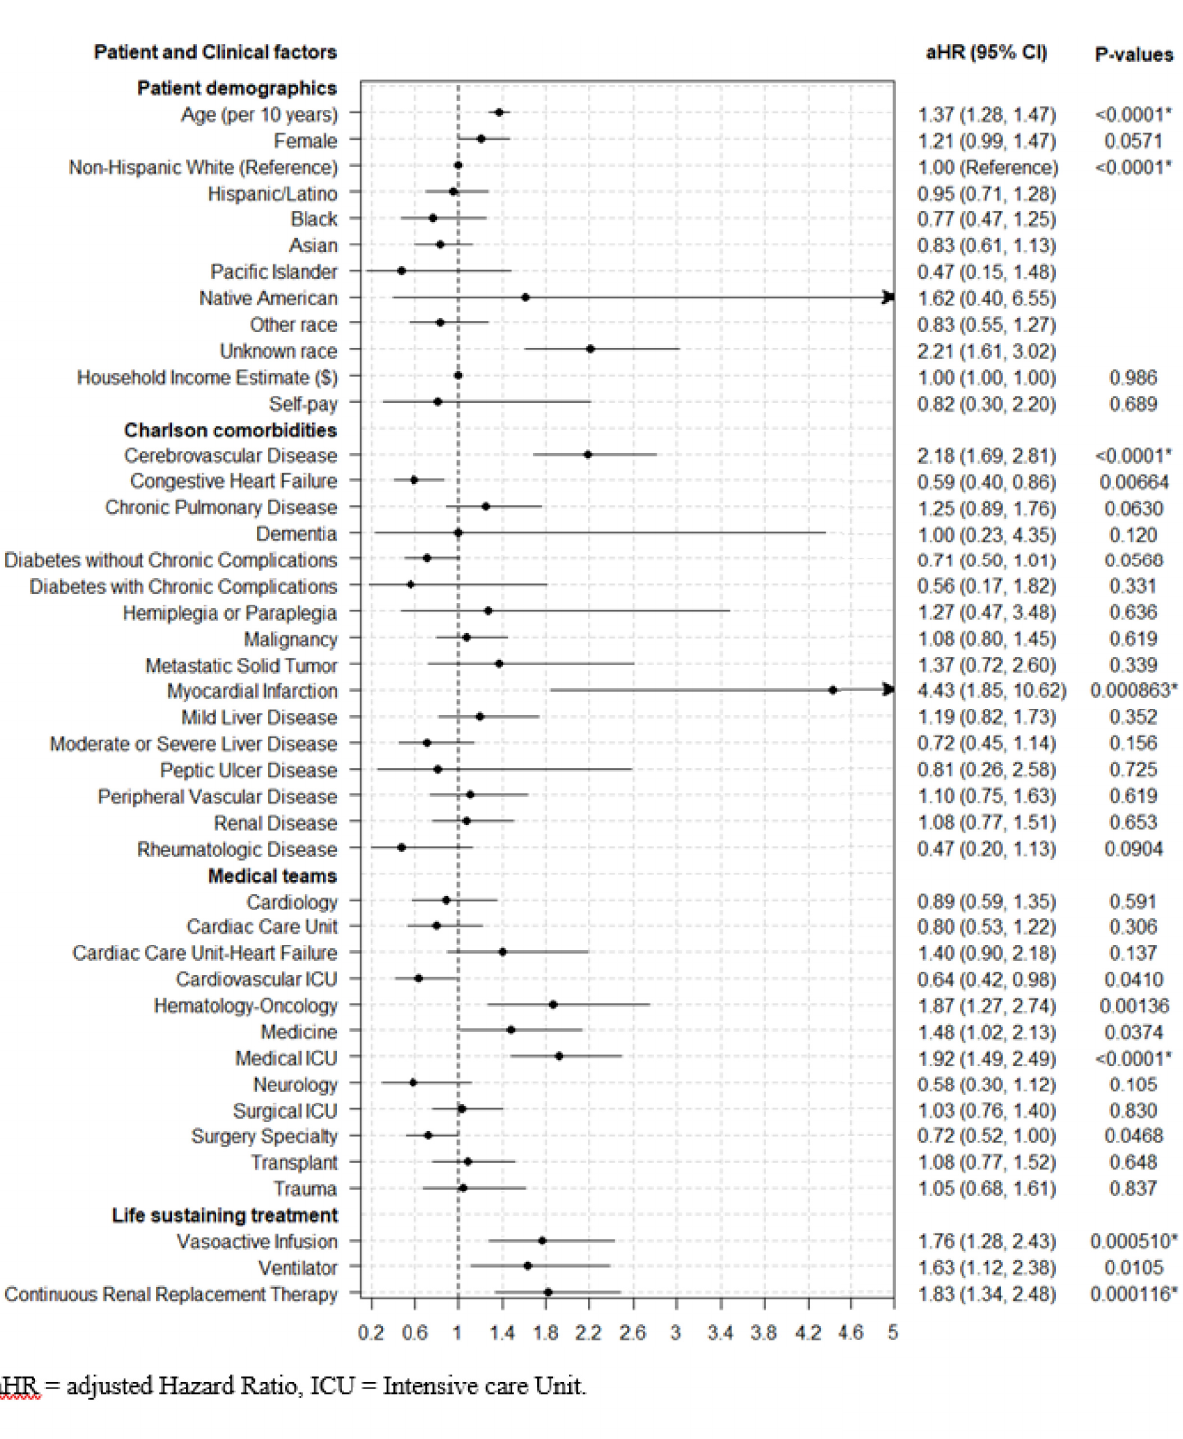
Fig 2. Predictors of ICU patients transitioning to Comfort Care. https://doi.org/10.1371/journal.pone.0190569.g002 PLOS ONE | https://doi.org/10.1371/journal.pone.0190569 February 28,